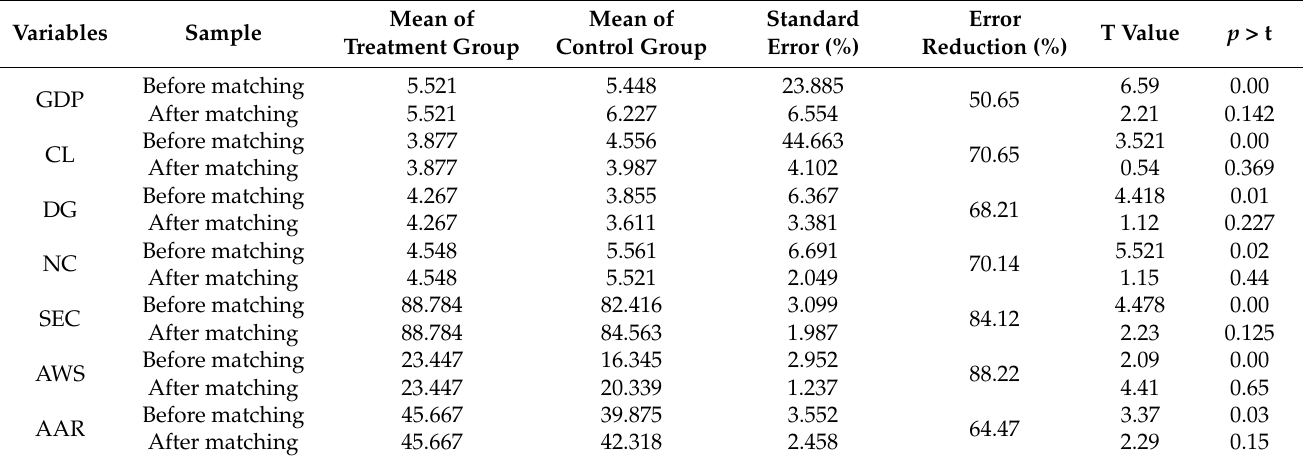
Table 2. Error reduction after